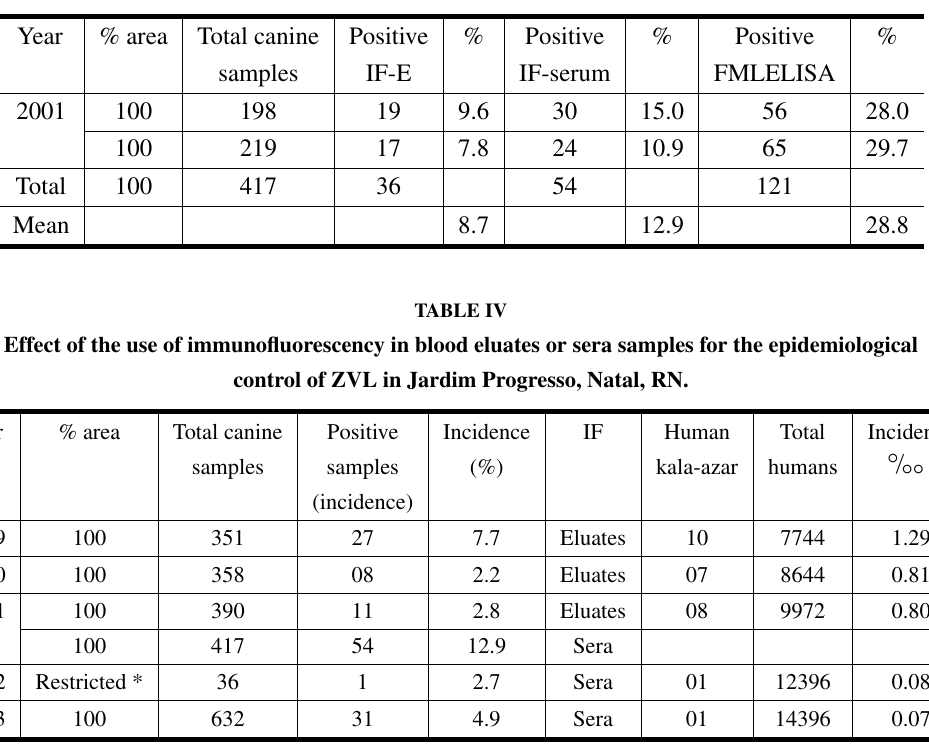
Comparison of seropositivities in immunofluorescency of blood eluates, sera and FMLELISA sera assay.